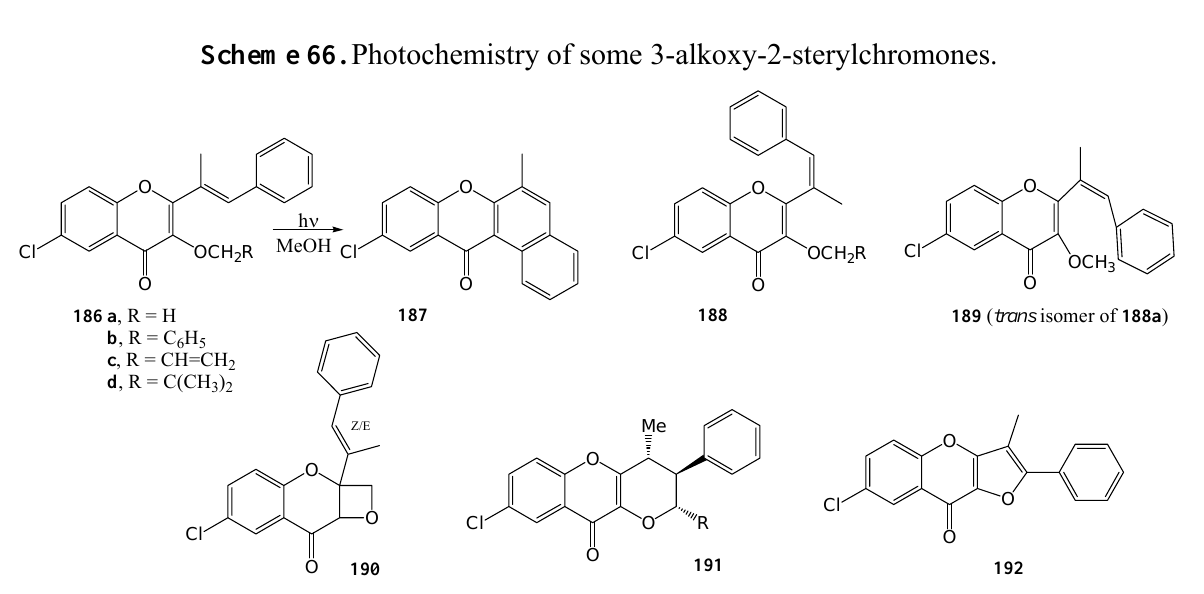
Table 15. Effect of substituents on the photochemistry of 3-alkoxy-2-sterylchromones.